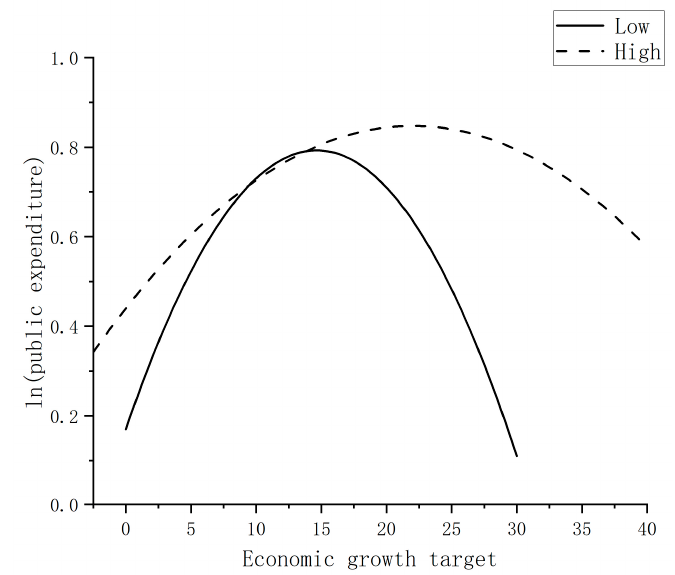
Figure 3. Moderating effect of land finance on public expenditure.